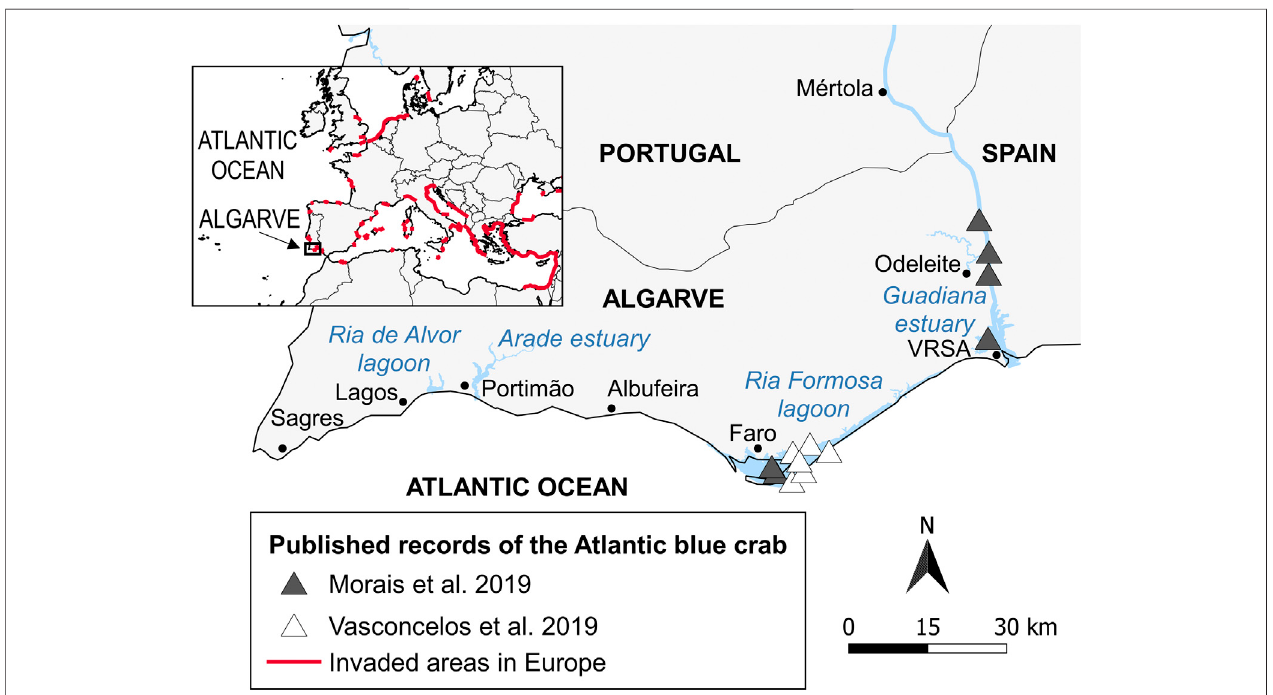
FIGURE1| LocationoftheAlgarveregion(southernPortugal,south-westernEurope),andtheareaswithpublishedrecordsoftheAtlanticbluecrabacrossEurope and the Algarve, based on the available literature. Maps generated with QGIS 3.12 Bucuresti (QGIS.org, 2021).